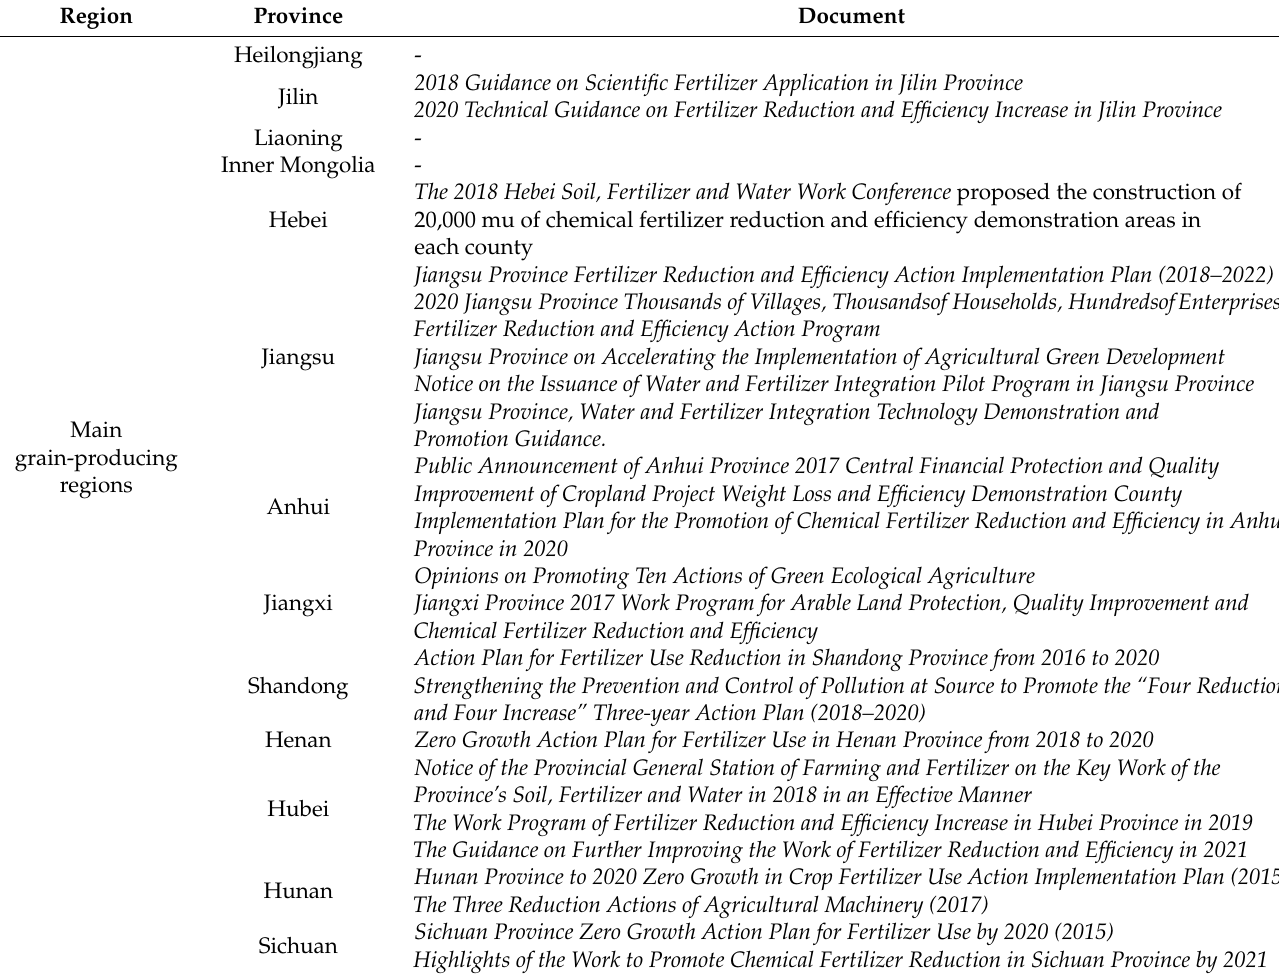
Table A1. Documents issued by local provincial governments related to fertilizer reduction and efficiency